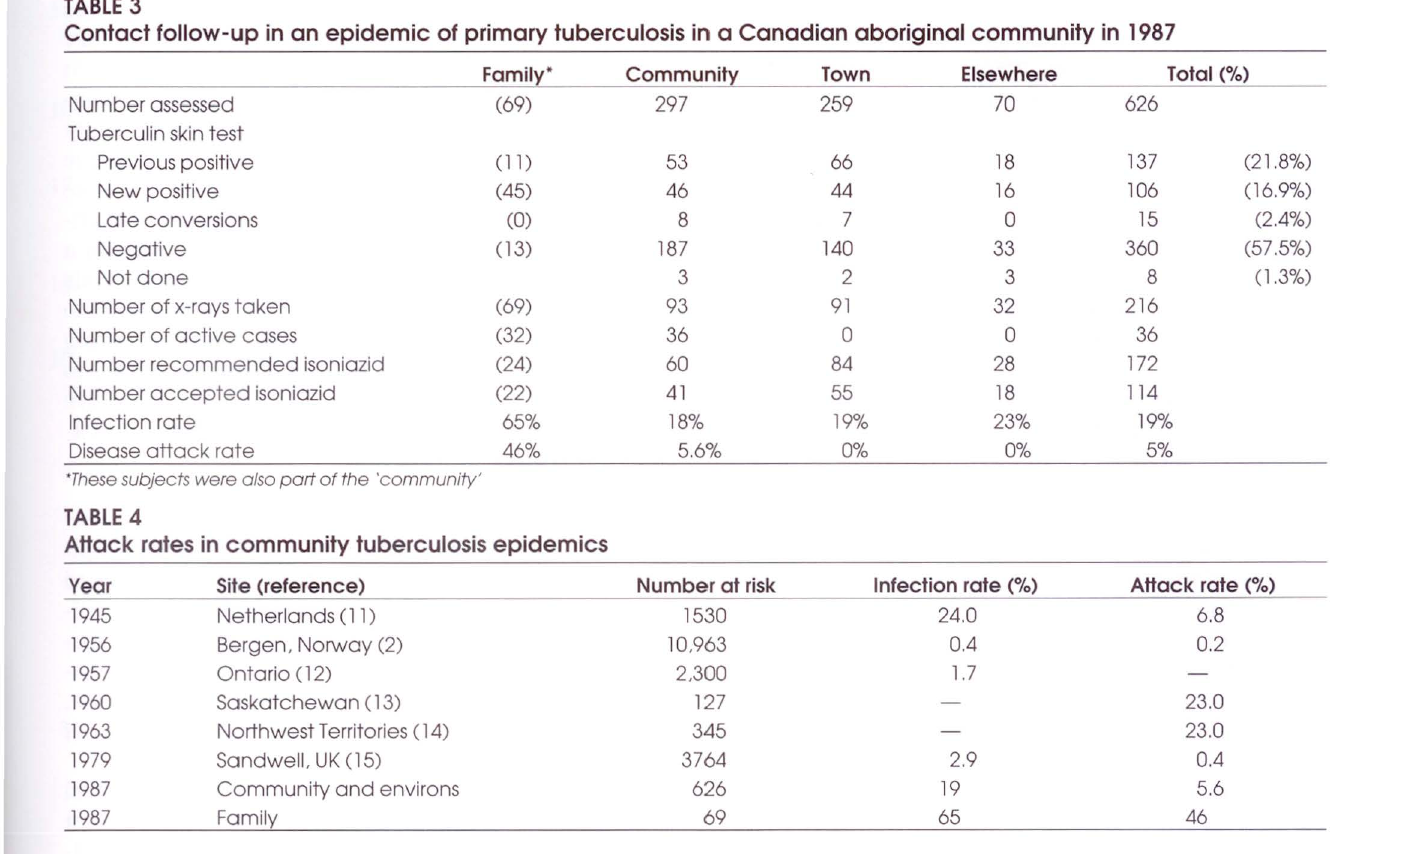
Attack rates in community tuberculosis